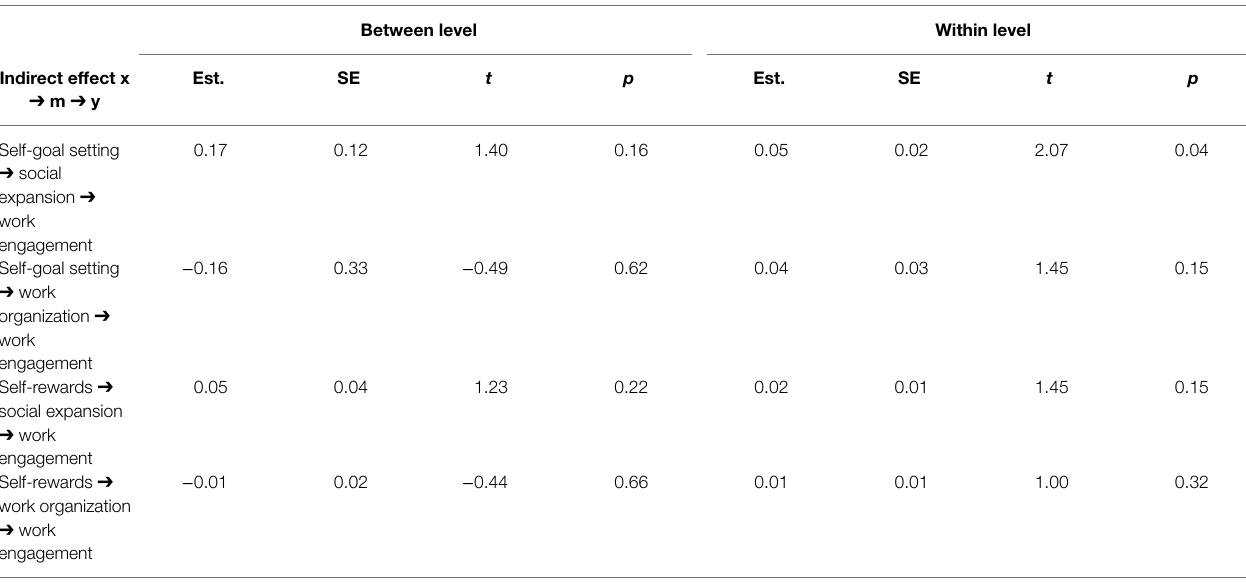
TABLE 4 | Indirect effects of self-leadership on work engagement via job crafting. Between level Within level